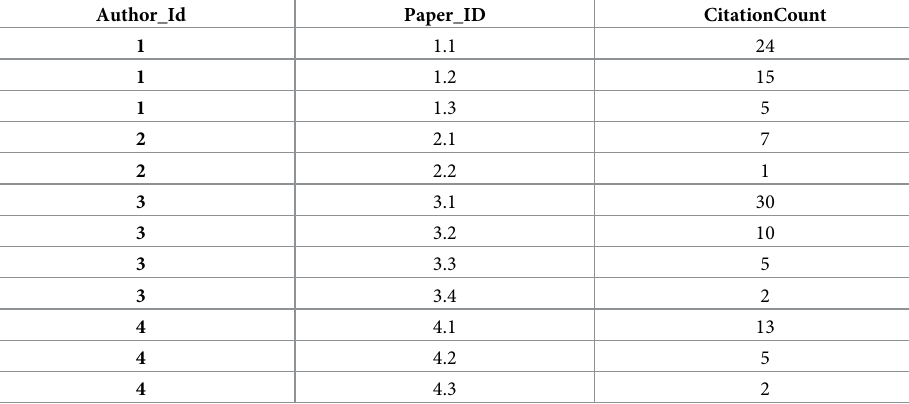
Table 2. Citation profile of authors